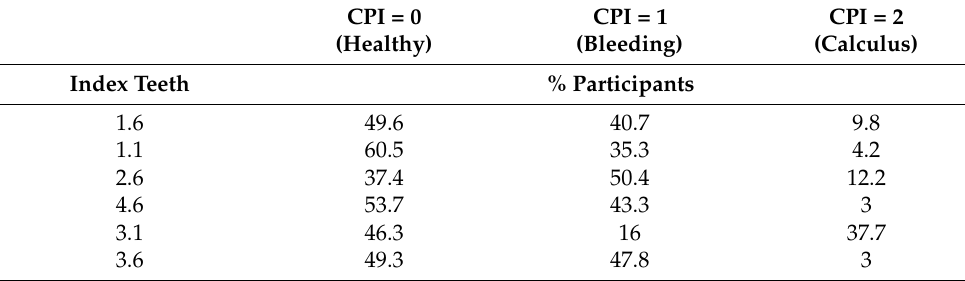
Table 5. Community Periodontal Index (CPI) values for index teeth.